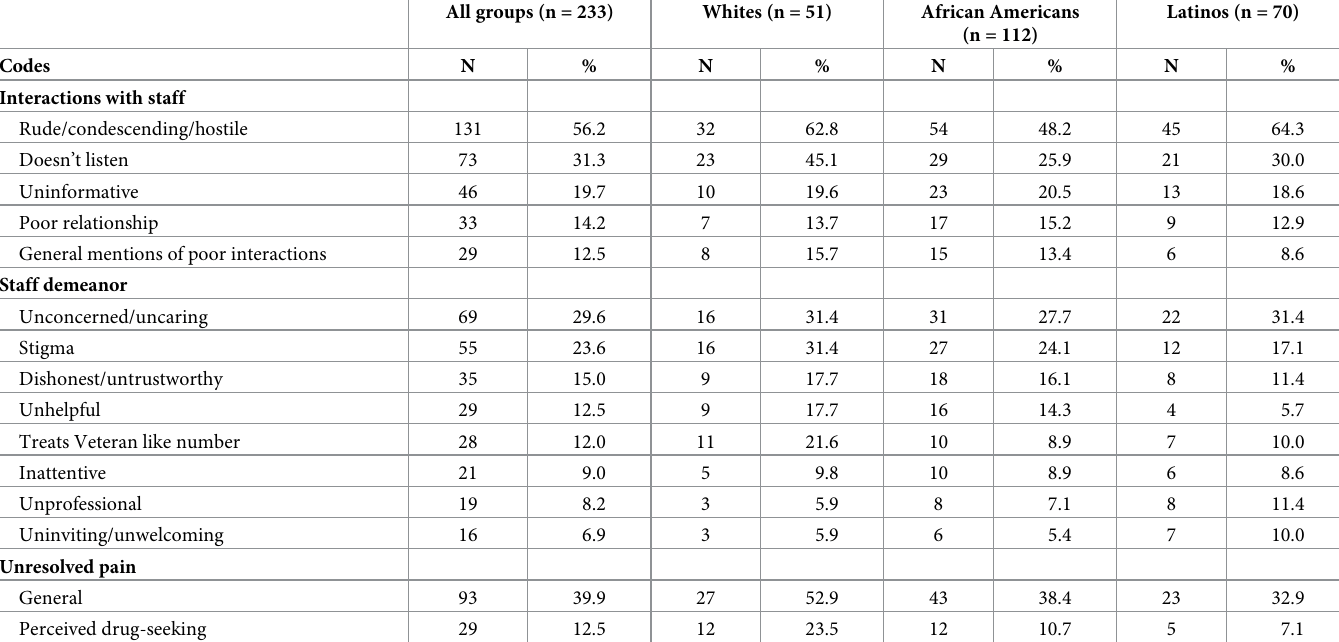
Table 6. Frequency of dissatisfaction codes in the domains of interactions with staff, staff demeanor, and unresolved pain expressed by patients who perceived any discrimination, stratified by racial/ethnic group. All groups (n =